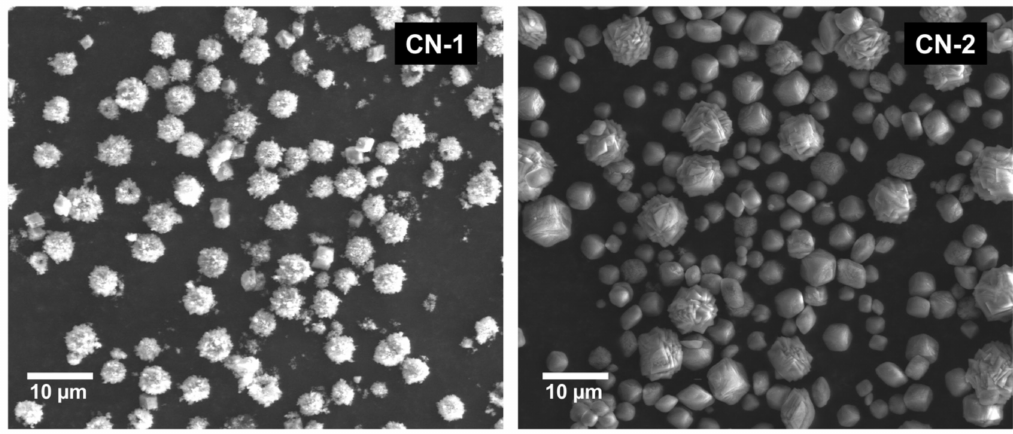
Figure 1. Scheme of the methodology followed for the preparation of MMC-1 and MMC-2 carbons.